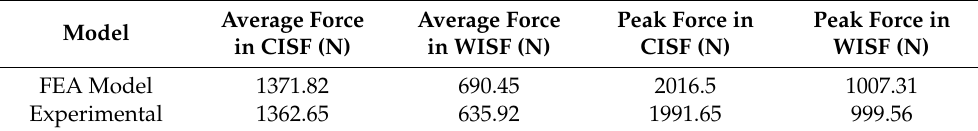
Table 8. Average and peak values of F Z obtained from FEA model and experimentally.